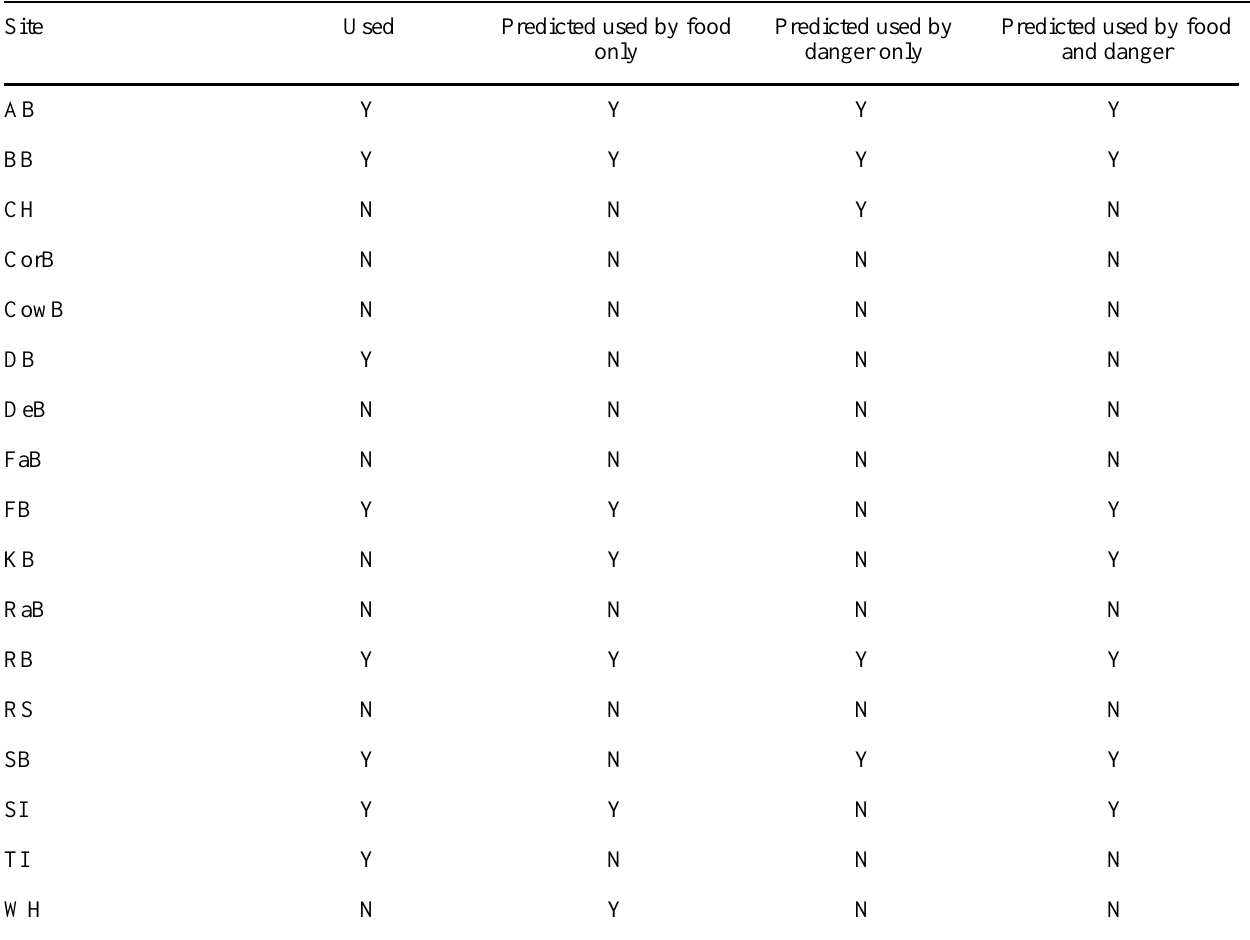
Site Used Predicted used by food